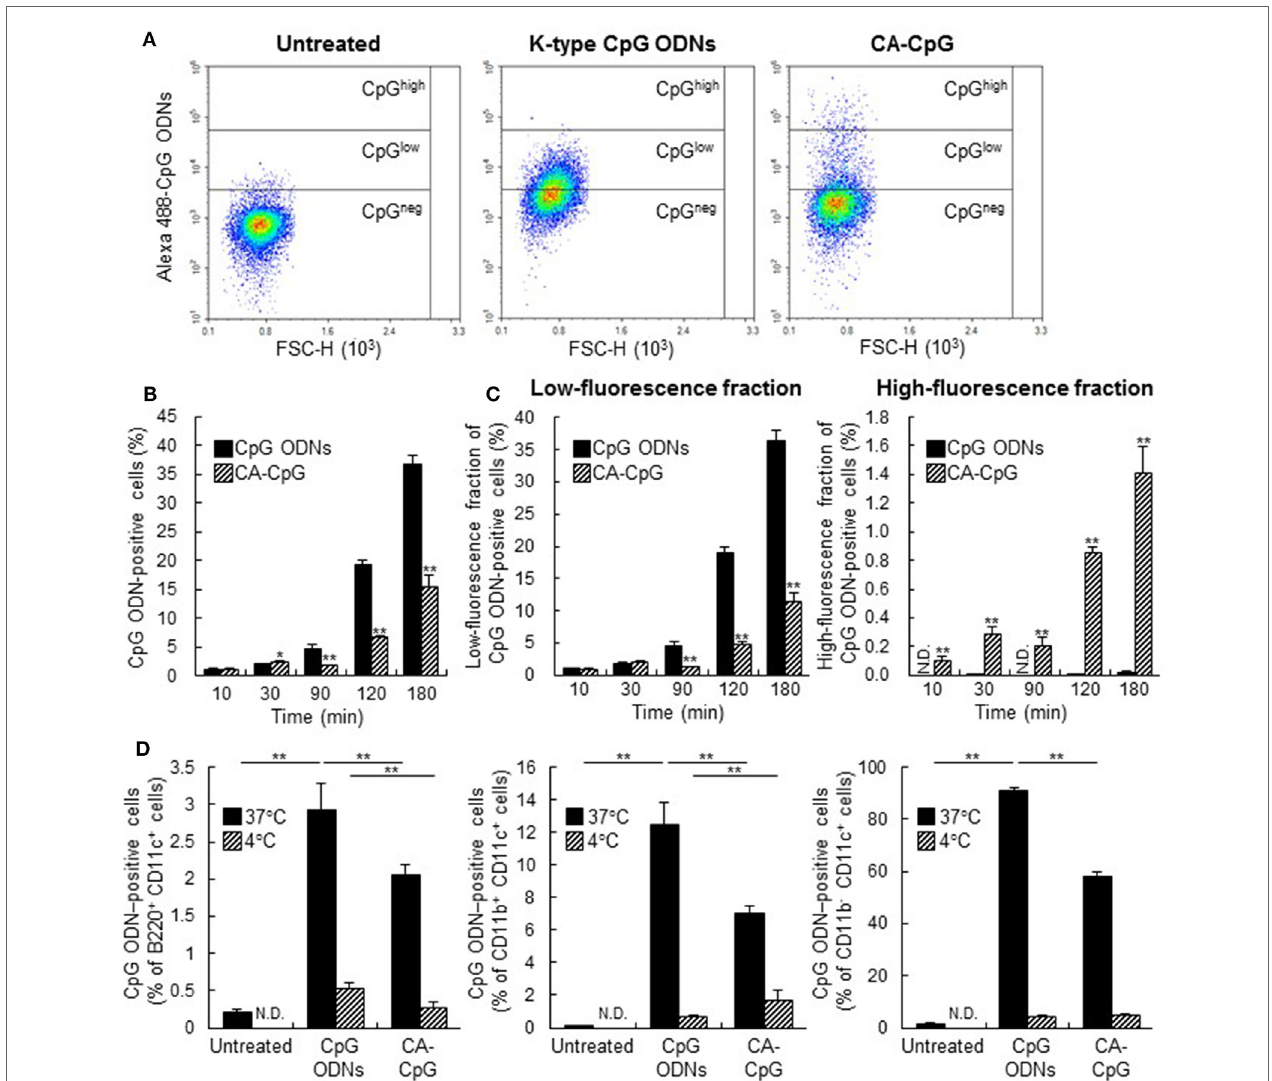
FigUre 3 | Cellular uptake of carbonate apatite (CA)-cytosine-phosphate-guanine (CpG). (a–c) Comparison of cellular uptake patterns of CA-CpG and K-type CpG oligodeoxynucleotides (ODNs). Mouse-derived dendritic cells (DCs) were treated with CA-Alexa 488-CpG or Alexa 488-labeled K-type CpG ODNs. At various time points after treatment, K-type CpG ODNs internalized in DCs were measured by flow cytometry after trypan blue quenching. (a) Representative dot plots show Alexa 488-labeled CpG ODNs in DCs vs. forward scatter (FSC-A). (B) Quantification of fluorescence revealed that uptake of CA-CpG into DCs was lower than uptake of K-type CpG ODNs, n = 5 per group. (c) Separation of the dot plots for the CpG ODN-positive fraction in panel (a) into graphs for high-fluorescence and low-fluorescence fractions revealed that the number of CpG ODNs taken up by each DC in the CA-CpG-treated groups was larger than that in the K-type CpG ODN-treated groups, n = 5 per group. (D) Subsets of DCs that took up CA-CpG. Mouse-derived DCs were treated with CA-Alexa 488-CpG or Alexa 488-labeled K-type CpG ODNs for 3 h at 4°C or 37°C. Uptake of CA-Alexa 488-CpG or Alexa 488-labeled K-type CpG ODNs into each subset of DCs was measured by flow cytometry without trypan blue quenching, n = 5 per group. Data are given as mean ± SD. * p < 0.05, ** p < 0.01 vs. K-type CpG ODN-treated group as indicated by Student’s t -test (B,c) or Dunnett’s test (D) . ND, not